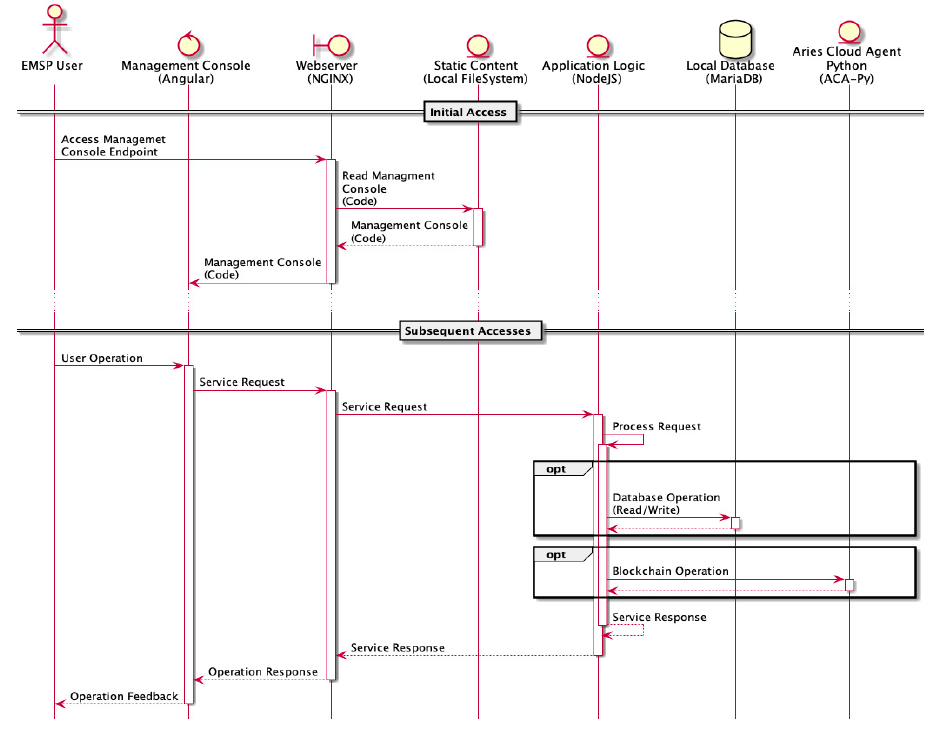
Figure 11. EMSP user originated sequence diagram.